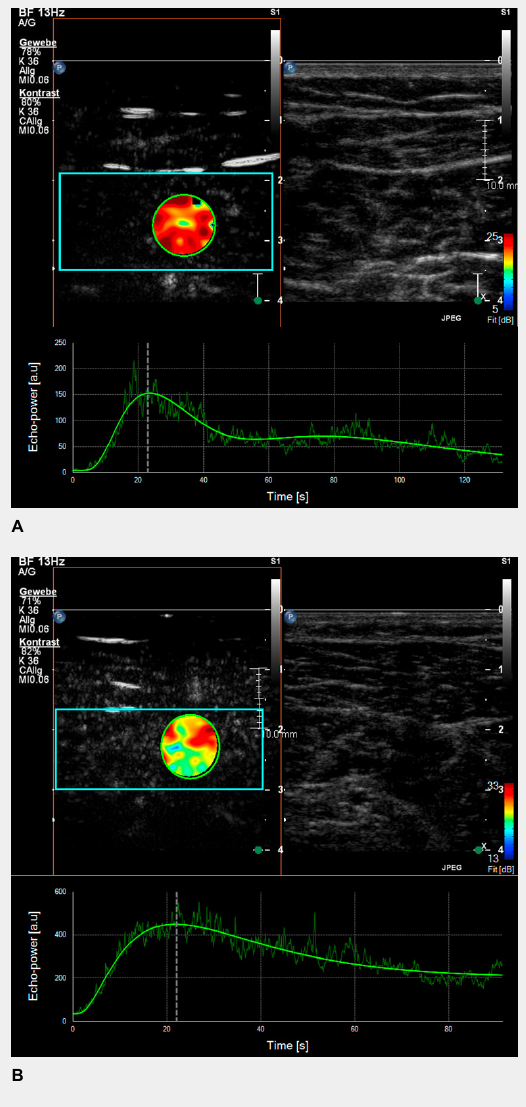
Skeletal muscle microperfusion on CEUS in a healthy volunteer (A) and a patient with peripheral artery disease (B). Corresponding time-intensity-curves of a region of interest (green circle) within the skeletal muscle (soleus muscle) after bolus injection of the ultrasound contrast agent with different shape in the healthy volunteer compared to the patient with peripheral artery